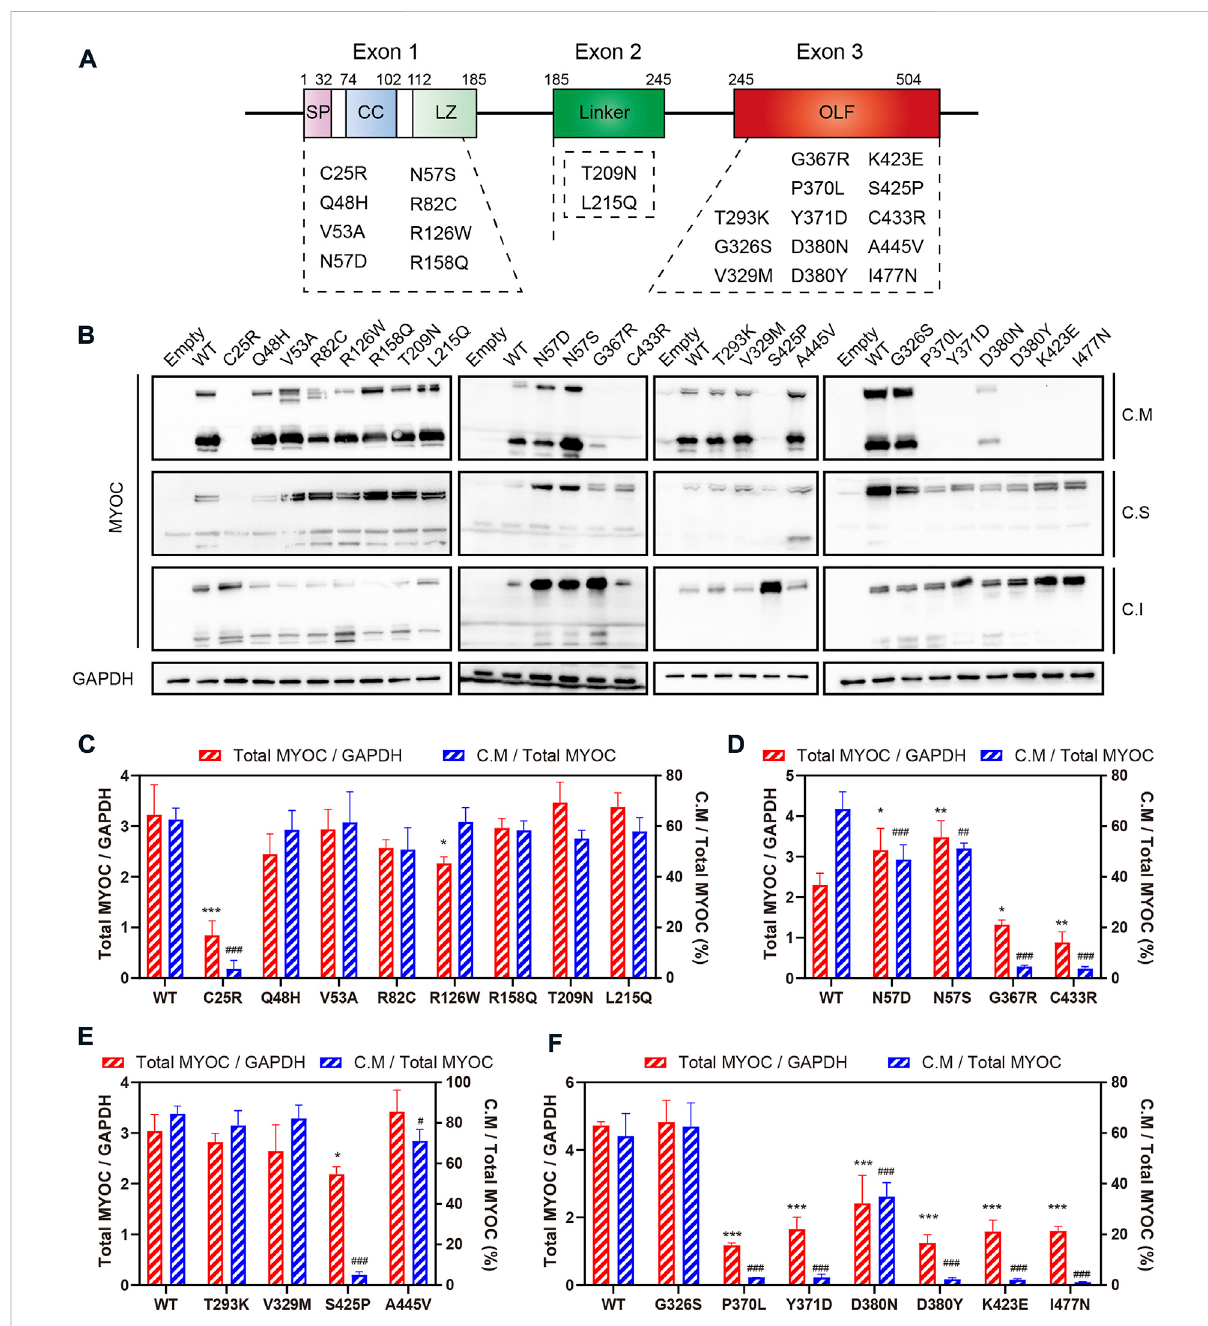
FIGURE 2 Secretion analysis of myocilin variants. (A) Structure ofmyocilin.MYOC gene has three exons, encoding myocilin that consists of signal peptide (SP), coiled-coil domain(CC), leucine zipper(LZ), linker and olfactomedin(OLF) domain. The variants listed in the dotted box are thevariants studied in this study. (B) Western blot analysis of intracellular and extracellular myocilin in HEK 293T cells expressing different MYOC variants. Forty-eight hours after transfection, myocilin was detected in the culture medium (C. M) and in RIPA-soluble and -insoluble cell fractions (C. S and C. I) by denaturing SDS ‒ PAGE. An MYOC antibody that recognizes the C-terminus of myocilin was used to detect expression of myocilin. (C – F) Densitometric analysis of immunoblotting bands. C.M = full myocilin detected in C.M + short C-terminal products detected in C.M. Total MYOC = C.M + C.S + C.I. N =